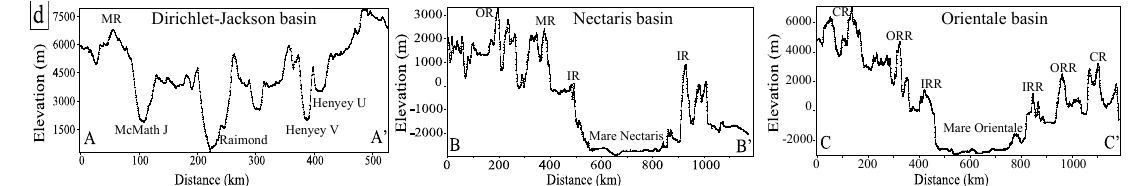
Figure 4. Topography map of Dirichlet–Jackson Basin, Nectaris Basin, and Orientale Basin and their surrounding areas (based on SLDEM data). Major rings of the basins are labeled by dashed lines. The red lines show the craters labeled in the maps. ( a ) Dirichlet–Jackson Basin. ( b ) Nectaris Basin. ( c ) Orientale Basin. ( d ) Topographic profiles across the three basins derived from SLDEM elevation data.